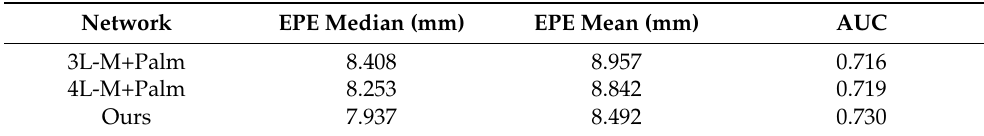
Figure 4. Comparative experiment of the effectiveness of the five-layer network. Table 1. Error analysis of five-layer network effectiveness.